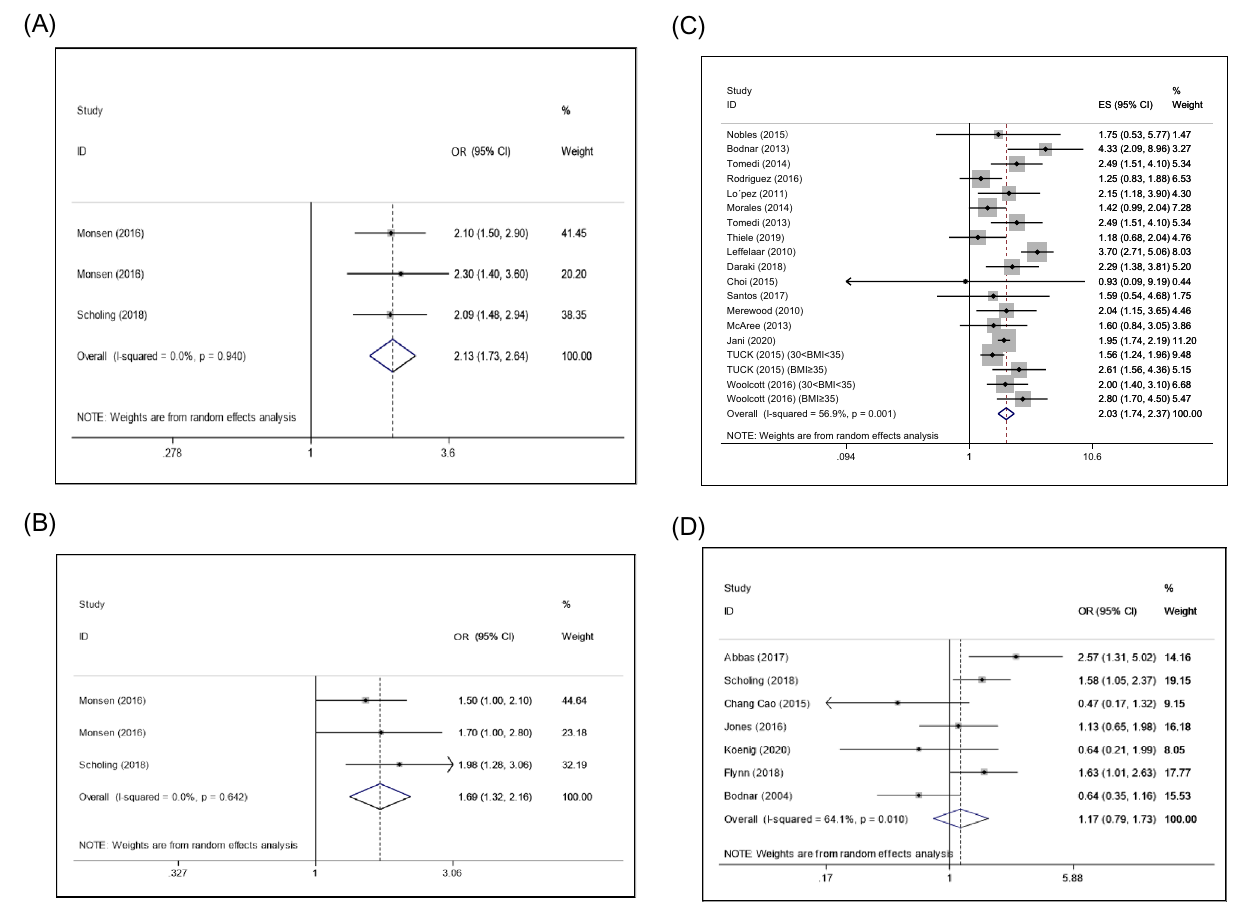
Figure 2. Forest plots of the relationship between prepregnancy obesity and micronutrient deficiency, including that of vitamin B12 ( A ), folate ( B ), vitamin D ( C ), and ferritin ( D